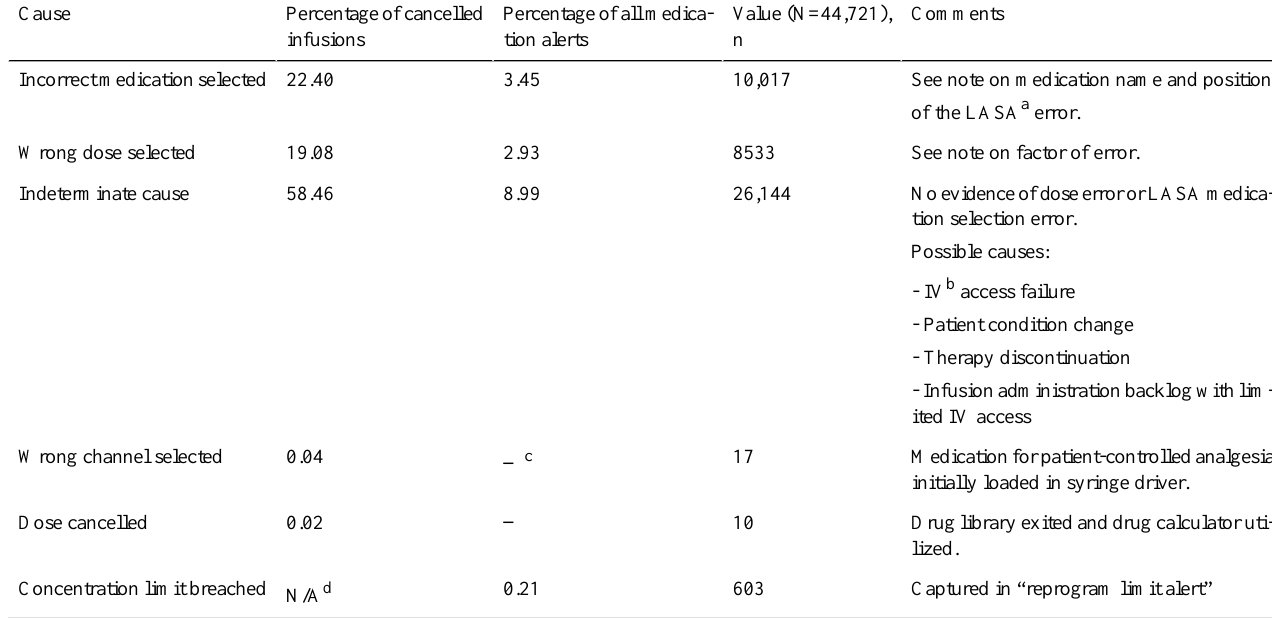
Table 4. Incidences of the causes for cancellation of